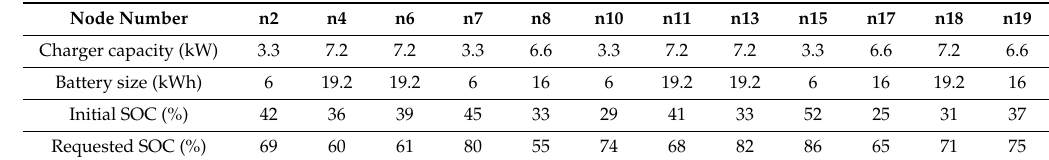
Table 1. An example of detailed input parameter of PEVs from a feeder.